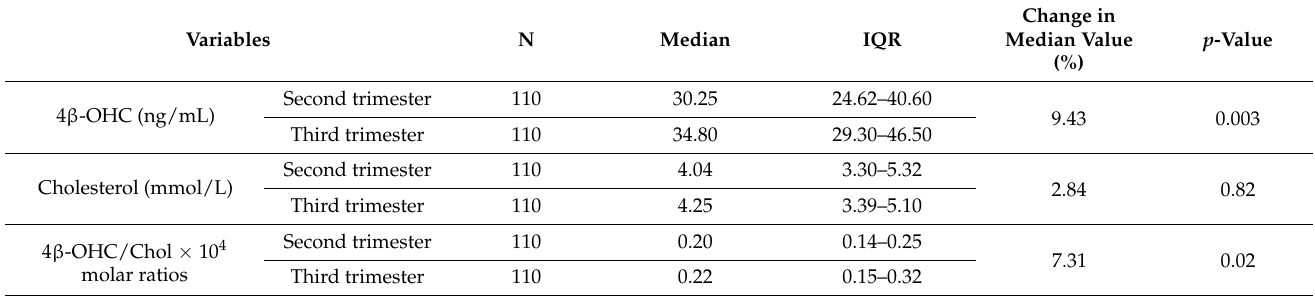
Table 2. Levels of 4 β -OHC, Chol and 4 β -OHC/Chol ratio during pregnancy.